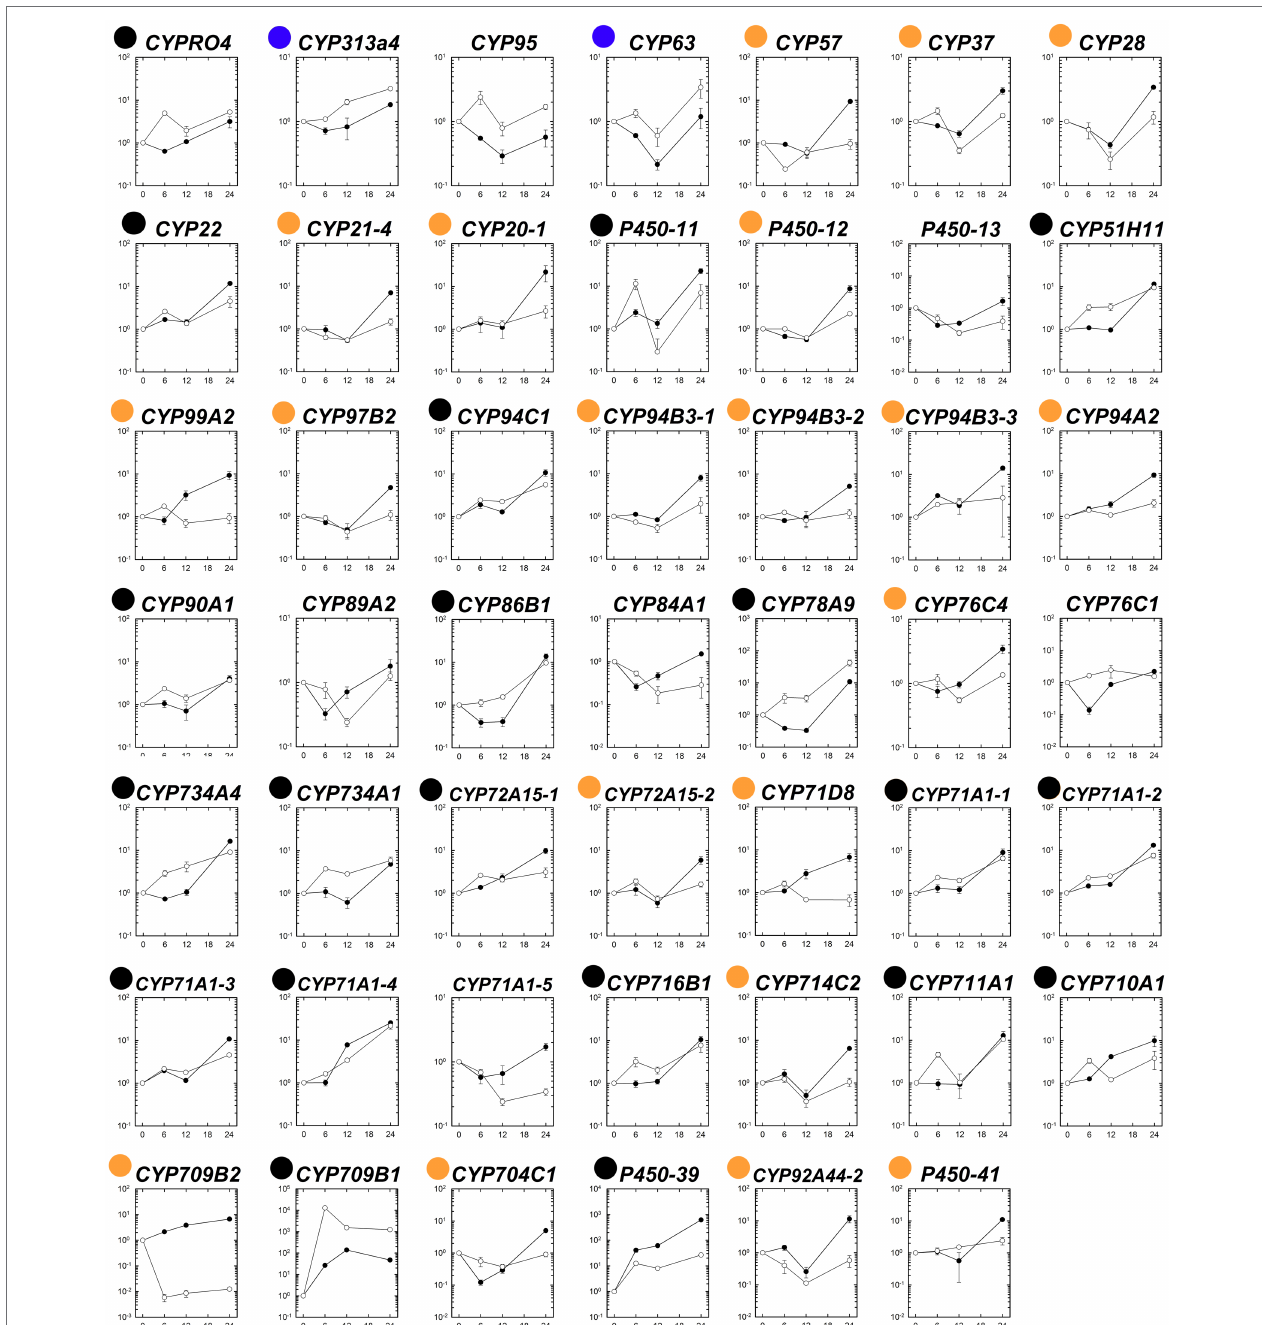
FIGURE 4 | Temporal dynamic changes in relative transcript levels of each putative P450 gene in the S ( ● ) and R ( ○ ) lines of Polypogon fugax under fenoxaprop- P -ethyl stress. The X-axis represents the time (h) after fenoxaprop- P -ethyl treatment, and the Y -axis represents the transcript levels relative to the untreated sample (0 h). Data are the mean values ± SEM. Black dots marked genes were up-regulated more than threefold in both the S and R lines by fenoxaprop- P -ethyl treatment for at least one time point, orange dots marked genes were up-regulated more than threefold only in the S line, and blue dots marked genes were up-regulated more than threefold only in the R